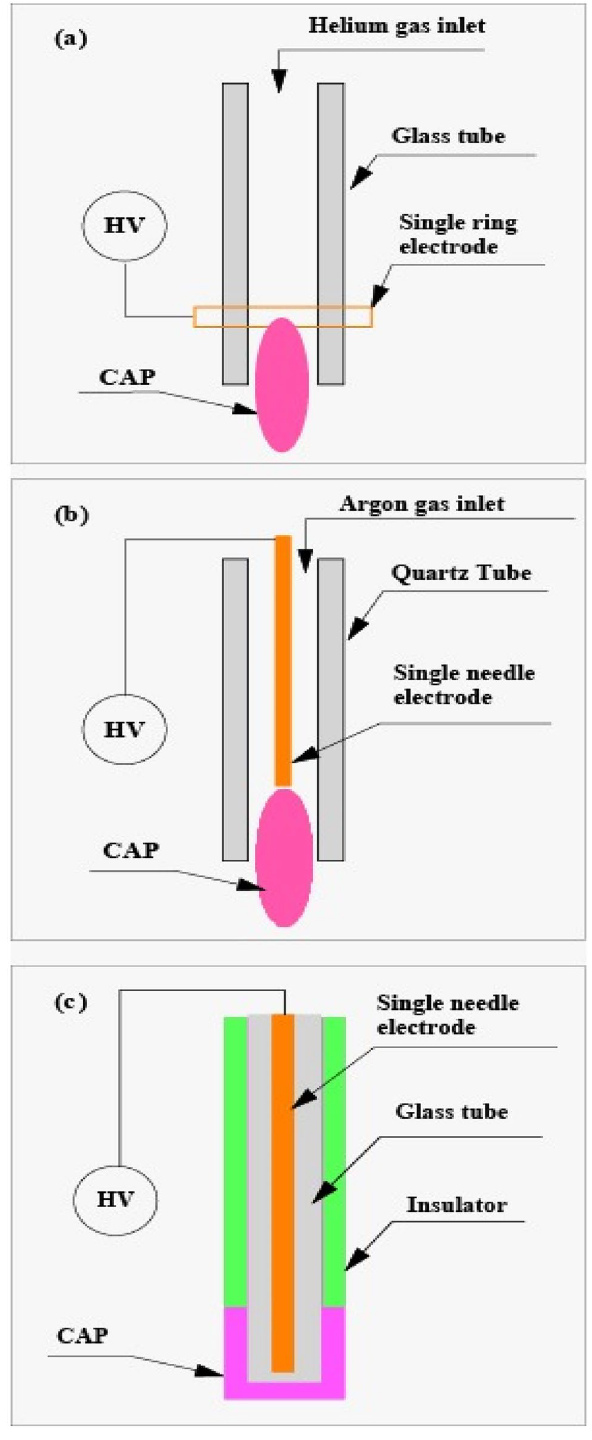
Figure 1. Schematic of cold-atmospheric pressure plasma devices used for enamel processing (a) He-DBDJ, (b) ArJ, (c)